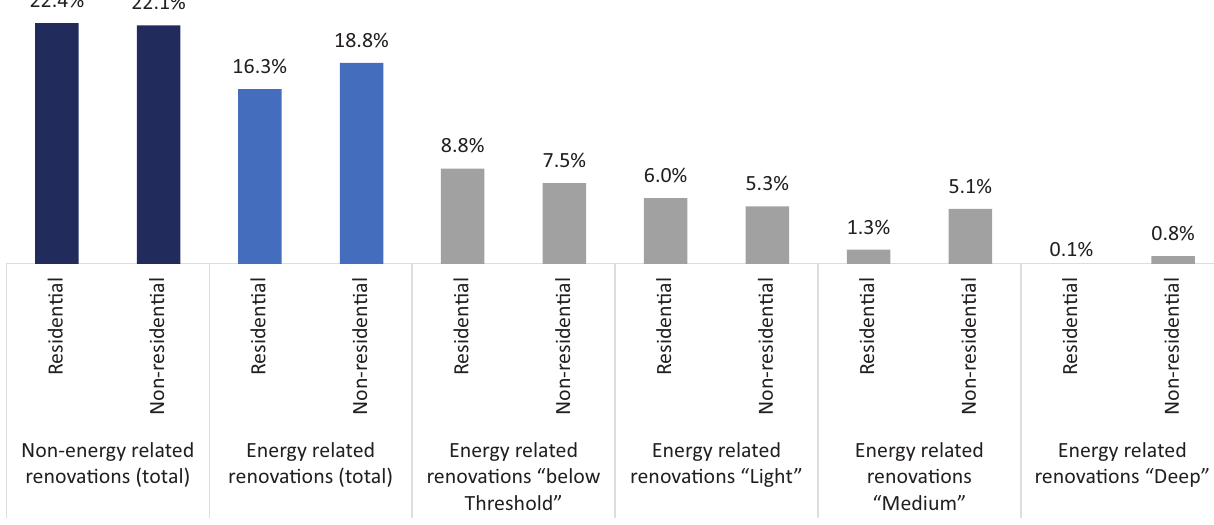
Figure 11. European Commission final report: Portugal’s data, 2012–2016. Source: European Commission (2019, p.